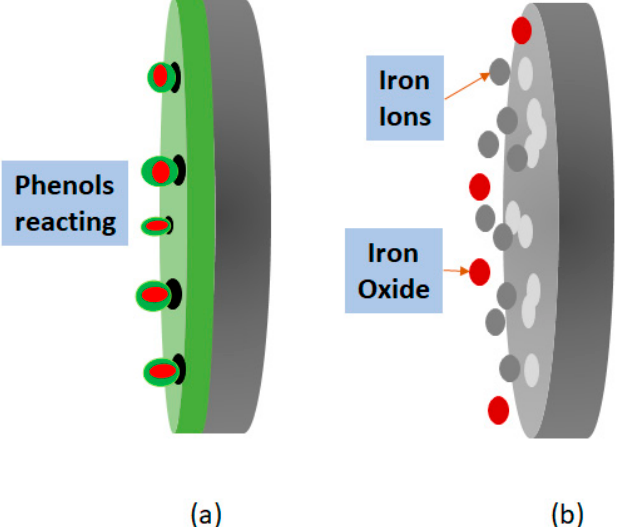
Figure 10. Schematic description of the phenomenology occurring for the prevention of deterioration by coating with natural corrosion inhibitors; ( a ) corrosion phenomenology with coating; ( b ) corrosion phenomenology without coating.